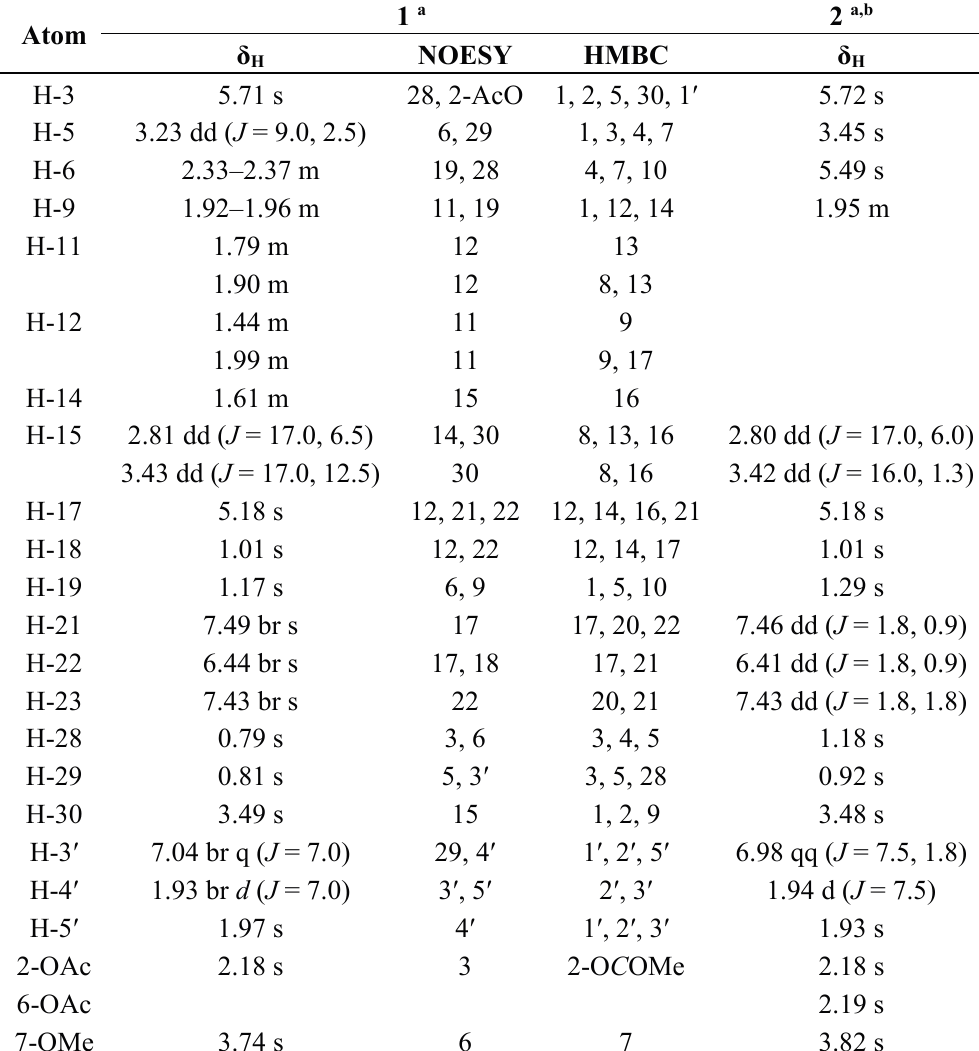
Table 1. 1 H-NMR, NOESY, and HMBC data of 1 and 2